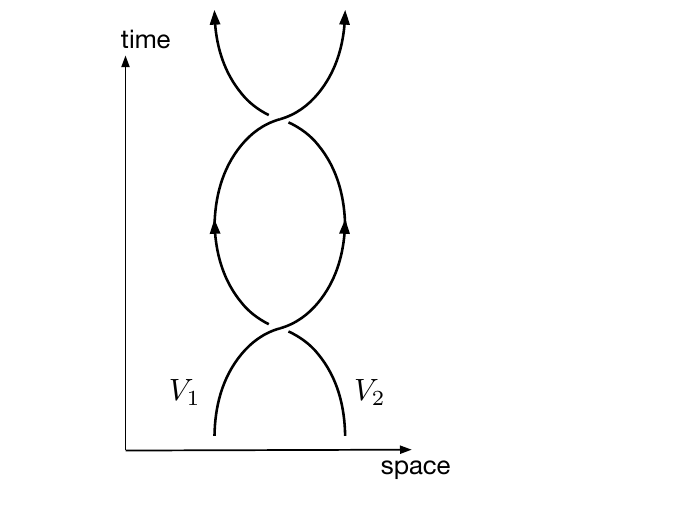
The world lines of two vortices rotating around each other in spacetime. The two vortices always keep (cid:12)nite spatial distance between